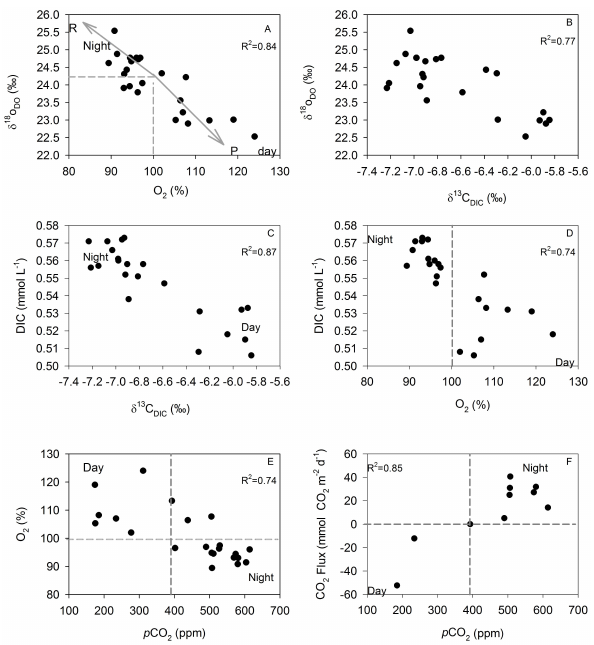
Fig. 11. Cross-plots showing behaviour of different biogeochemical parameters during the diurnal cycle at Chania Stream between 12 and 13 September 2009.